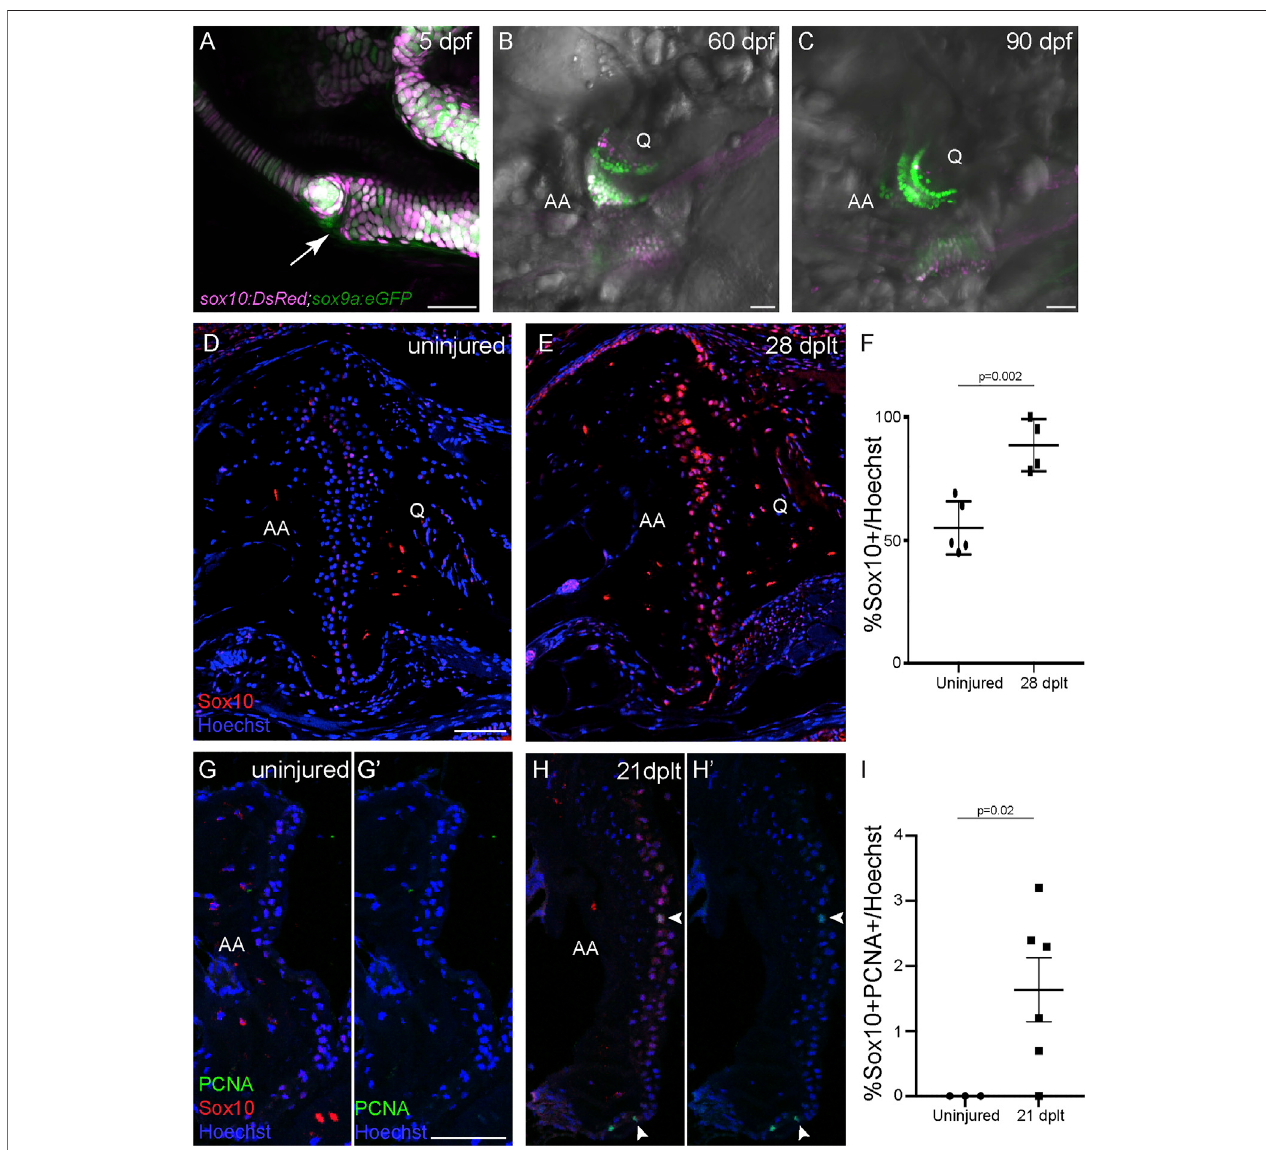
FIGURE 2 | Sox10 expression is upregulated during cartilage regeneration. (A – C) sox10:DsRed and sox9a:eGFP are broadly co-expressed in chondrocytes at 5dayspost-fertilization(dpf),and sox10:DsRed becomesrestrictedtoasubsetofjointchondrocytesat60and90dpf.Thearrowshowsthedevelopingjawjointat5dpf. (D,E) AntibodystainingoftheadultjawjointshowsendogenousSox10protein(red)injointcellsin1-year-olduninjuredcontrol (D) andinteropercular – mandibular(IOM)- transectedanimalsat28dayspost-ligamenttransection(dplt) (E) . (F) Quanti fi cationofSox10+cellsasapercentage oftotalHoechst+cellsatthejawjointarticular surface. Individual data points, mean, and standard error of the mean are shown. The p -value is calculated by two-tailed Student ’ s t -test. (G,H) Antibody staining for PCNA (green) and Sox10 (red) of adult jaw joints from uninjured controls (G,G 9 ) and IOM-transected animals at 21 dplt (H,H 9 ) . The white arrowheads indicate double- positive PCNA+/Sox10+ nuclei. (I) Quanti fi cation of double-positive PCNA+/Sox10+ chondrocyte nuclei as a percentage of total Hoechst-stained nuclei at the jaw joint articularsurface.Individualdatapoints,mean,andstandarderrorofthemeanareshown.The p -valuewascalculatedusingWelch ’ stwo-tailed t -test.AA,anguloarticular bone; Q, quadrate bone. Scale bars (cid:1) 50 μ